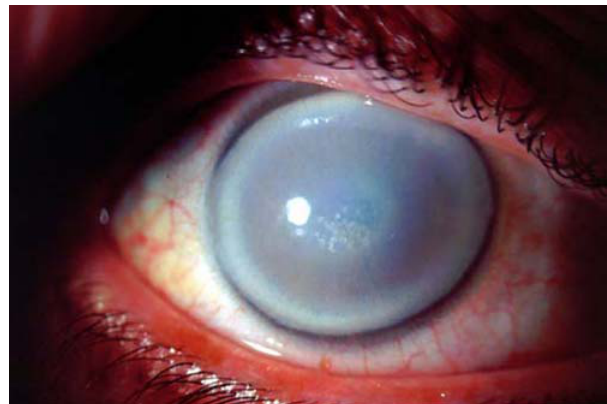
Figure 1. Slit lamp image of the right cornea from a 50-year old affected member of family 105, demonstrating a ‘‘bull’s eye’’ morphology of central and peripheral corneal clouding associated with a relatively spared mid-peripheral zone. Central subepithelial crystalline deposits and prominent corneal arcus are also present.